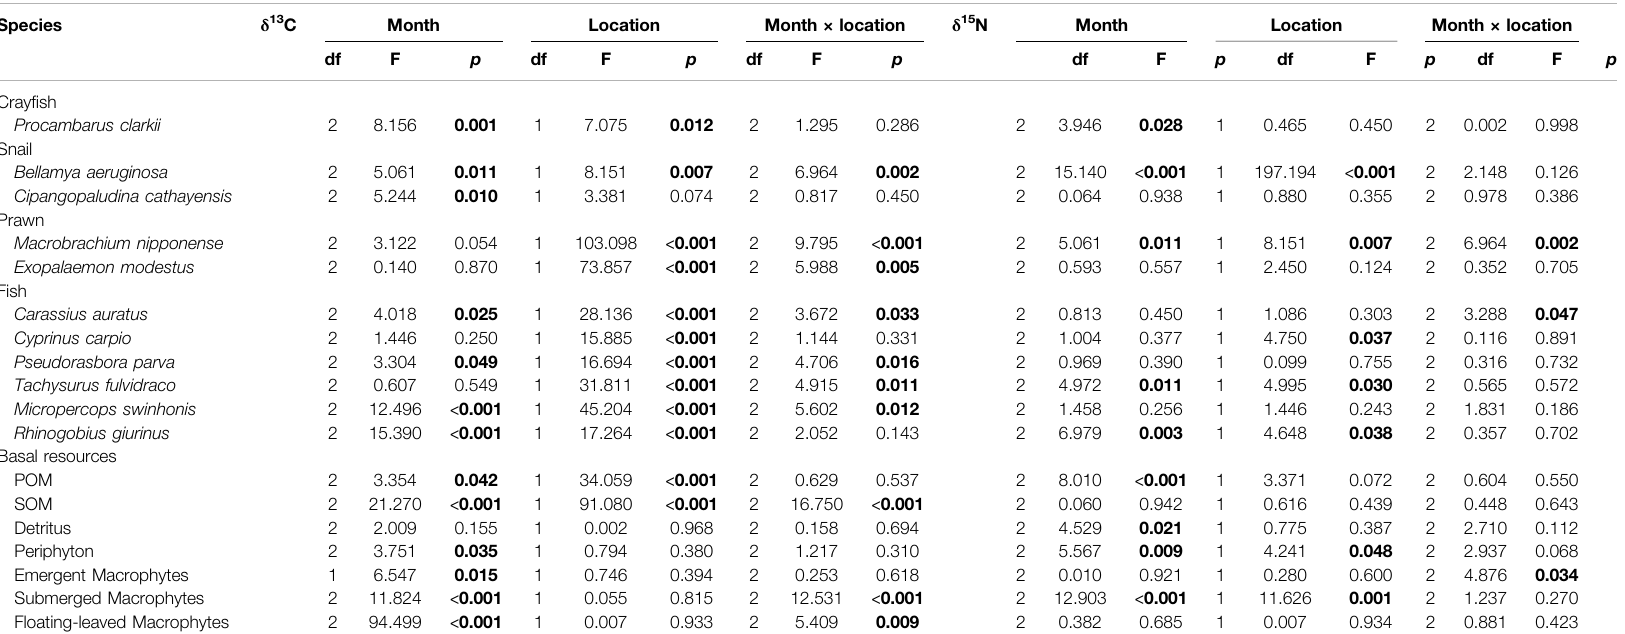
TABLE 2 | Results from two-way analysis of variance (two-way ANOVA) testing for effects of month and location on δ 13 C and δ 15 N, bold font denotes statistically signi fi cant values ( p < 0.05). POM = suspended particular organic matter, SOM = organic matter in surface sediments.